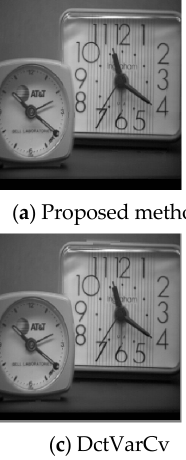
Figure 9. The fusion result of the aircraft image.